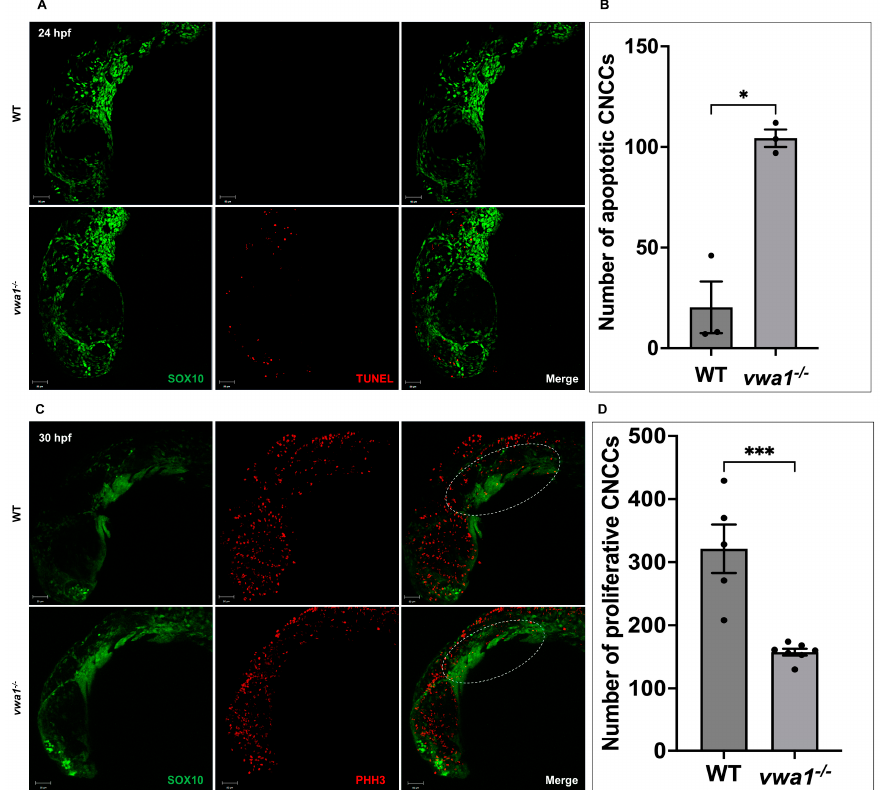
Figure 5. Increased apoptosis and decreased proliferation of cranial neural crest cell in vwa1 mutant embryos. ( A , B ) TUNEL staining (red fluorescence) revealed increased cell apoptosis in the cranial region and dorsal tissues of vwa1 mutant embryos at 24 hpf. SOX10 marked CNCCs. ( C , D ) PHH3 staining (red fluorescence) showed decreased cell proliferation in the cranial region of vwa1 mutant embryos at 30 hpf. SOX10 marked CNCCs. The pharyngeal arches are marked with dotted white circles. * p < 0.05; *** p < 0.001.